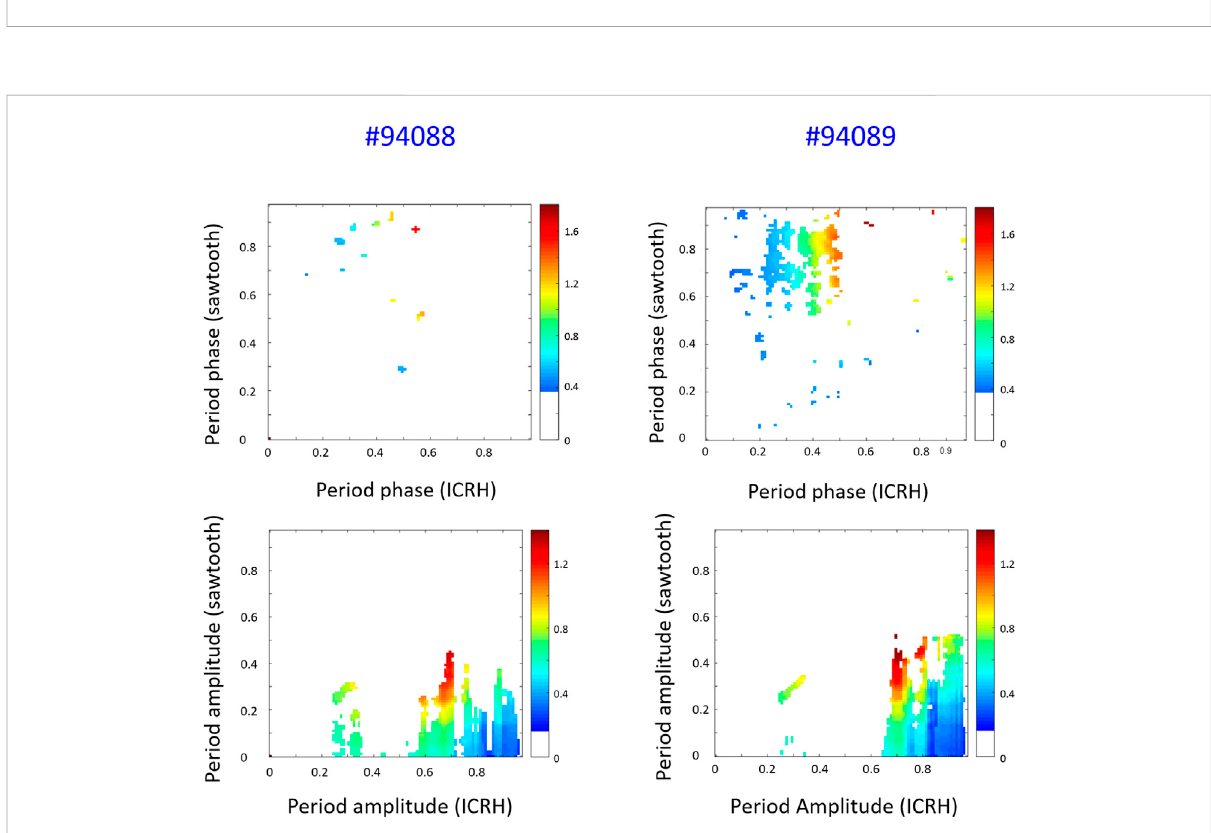
FIGURE 15 ComparisonoftheCMIforthephase-phase(toprow)andamplitude-amplitude(bottomrow)synchronisationofthedischarges90,488 (A) and 90,489 (B) . The colour code represents the level of coupling derived with the conditional mutual information CMI. CMI plots are shown with the period of the driver time series (ICRH) on the x -axis and driven time series (sawtooth) on the y -axis. Periods are measured in seconds. Shown are the positive signi fi cance-level deviations from the 99th percentile of the average CMI calculated using 50 Fourier transform